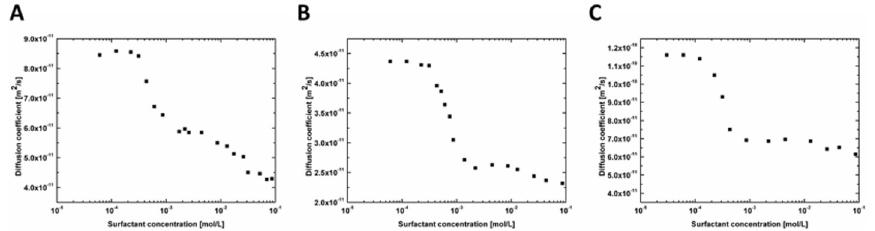
Fig 2. The diffusioncoefficient for the β -lactoglobulin-SDS(A), transferrin-SDS (B) and humaninsulin-SDS (C) complexes as a function of SDS concentration determinedusing the Taylor dispersion analysis.